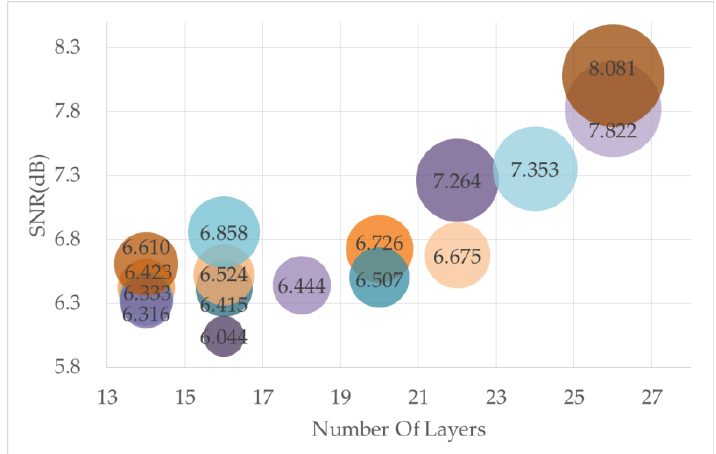
Figure 8. Denoising results of real seismic data with SNR of −7.116 dB for DWT-Resnet networks with a different number of layers for a fixed number of wavelet bases and wavelet decomposition levels.